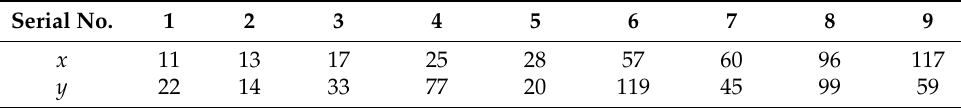
Table 1. The results of k-means. Serial